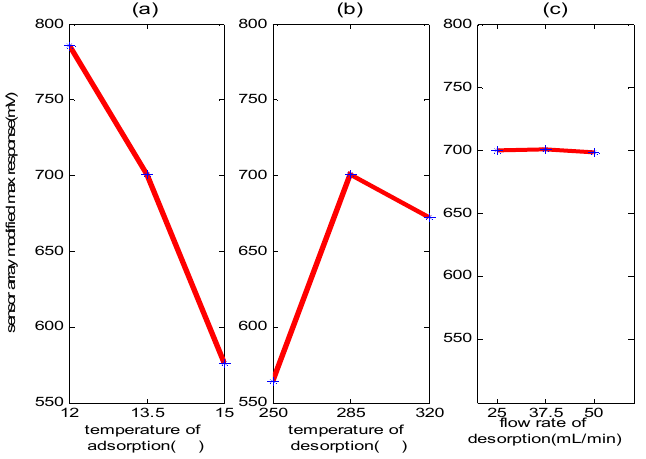
Figure 4. The influence of parameters for system condensation effects. (a) The influence of trapping temperature; (b) The influence of desorption temperature; and (c) The influence of desorption flow rate.